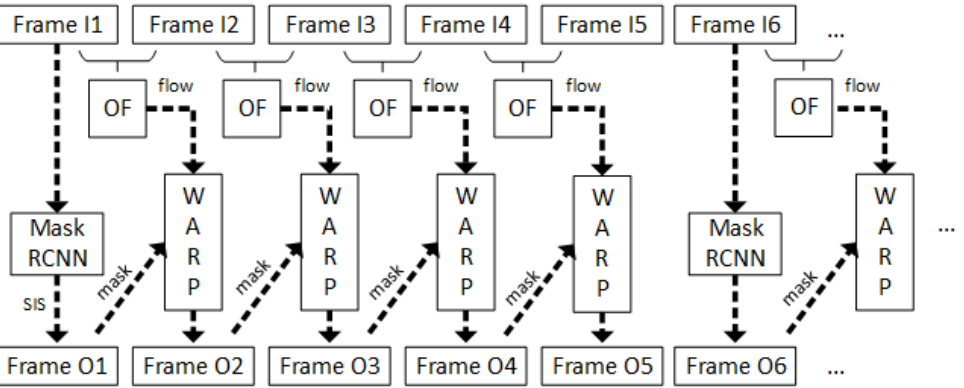
Figure 3. Semantic instance segmentation pipeline, where FrameI i —input frame i , FrameO i — semantic instance segmentation output for frame i , OF —Optical Flow method, WARP —image warping, and MaskRCNN —semantic instance segmentation neural network [3].